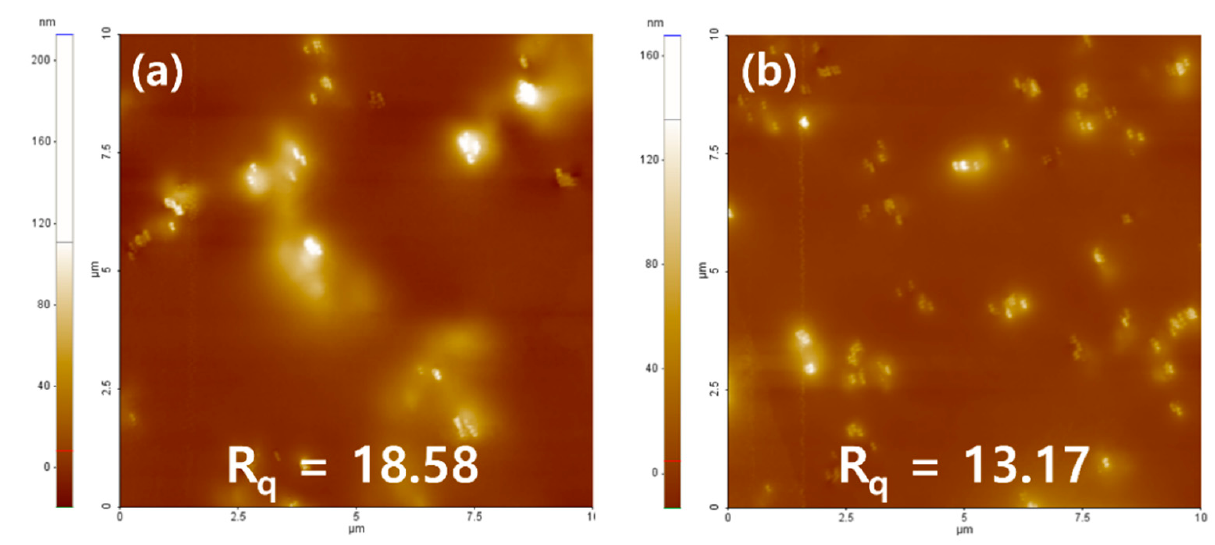
Figure 7. AFM analysis of ( a ) PN sample and ( b ) PNM3 sample.